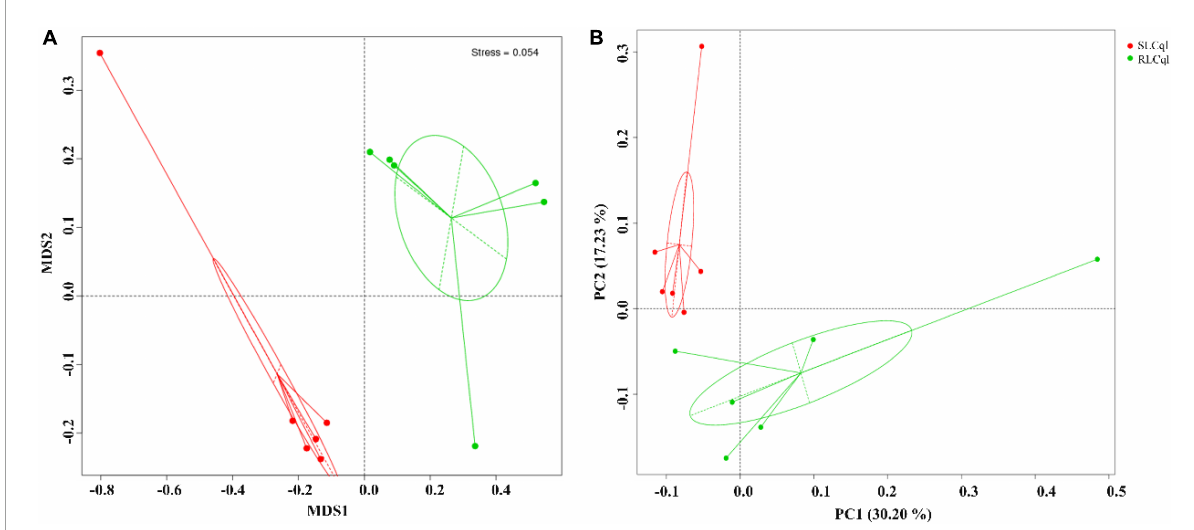
FIGURE3 Beta diversity analysis of symbiotic gut bacteria from strains that are susceptible and resistant to Lysinibacillus sphaericus C 3 -41. (A) Non-metric multidimensional scaling (NMDS), (B) unconstrained principle coordinate analysis (PCoA).